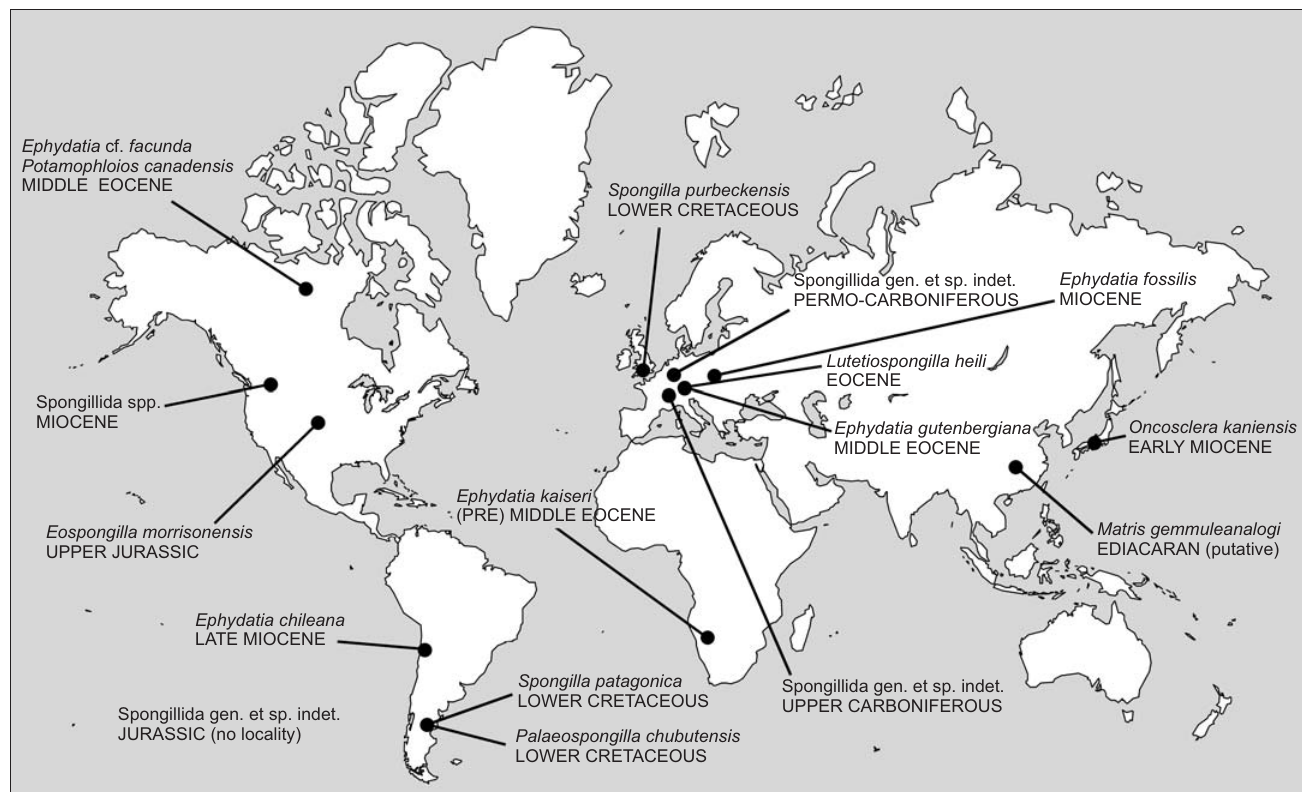
Fig. 6. Geographic distribution of fossil freshwater sponges (Porifera, Demospongiae,